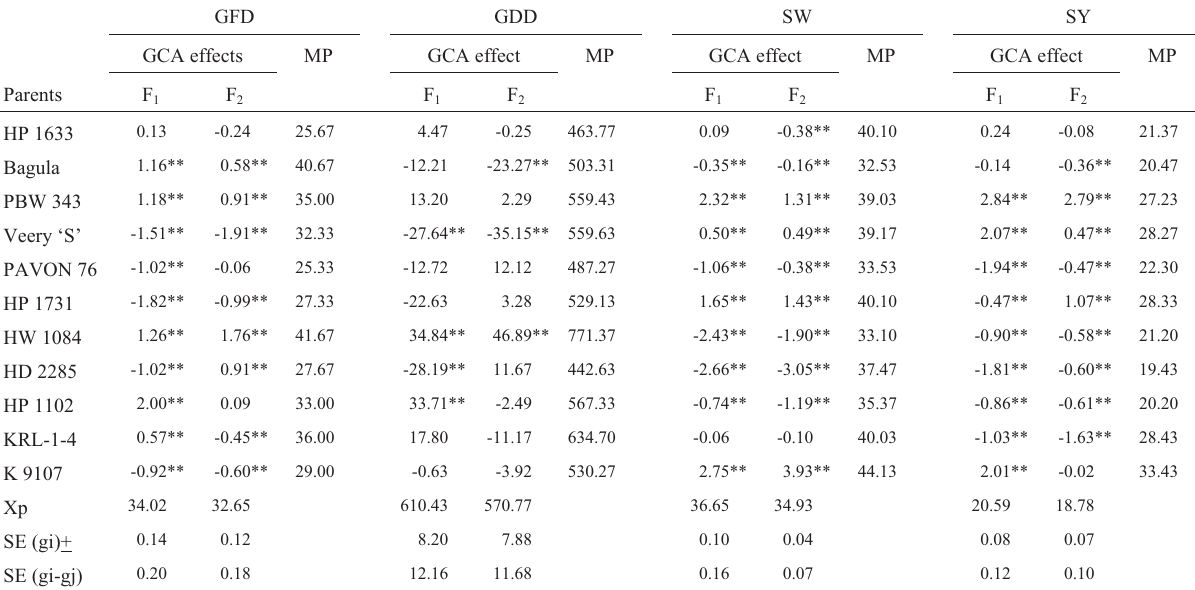
Table4 -Estimatesofgeneralcombiningability(GCA)effectsfortheF 1 andF 2 offspringof11wheatparentsandtheirmeanperformance(MP)forgrain filling duration (GFD), GFD for growing degree days (GDD), 1000 seed weight (SW) and seed yield (SY) per plant. GFD GDD SW SY